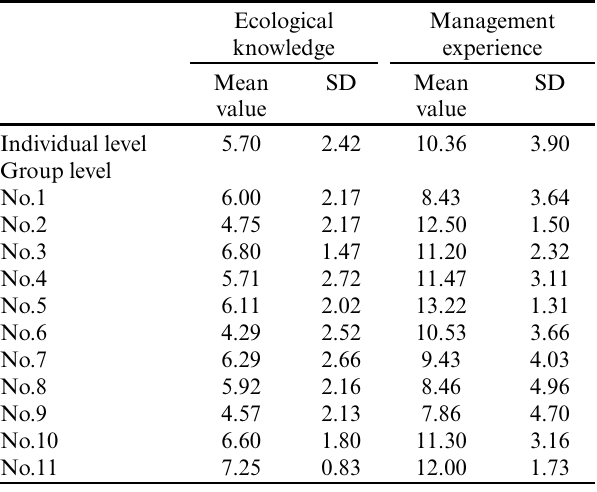
Table 5 . Summary of knowledge and experience values.